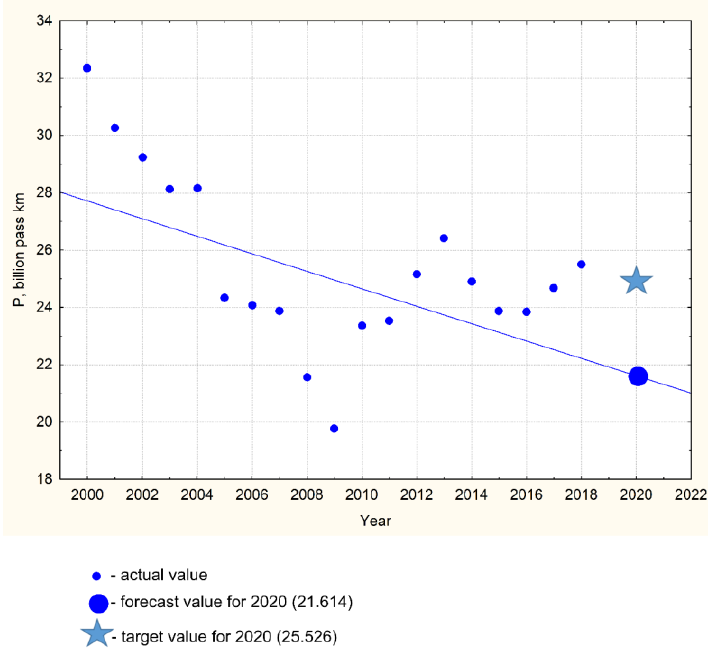
Figure 8: Assessment of the attainability of the goals for the completed passenger turnover